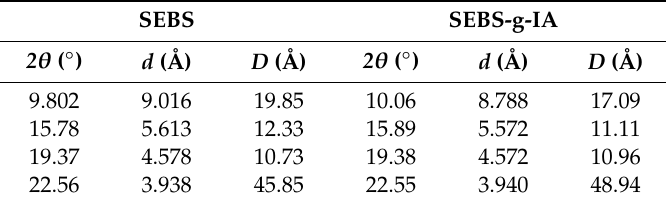
Table 2. XRD data of SEBS and SEBS-g-IA.